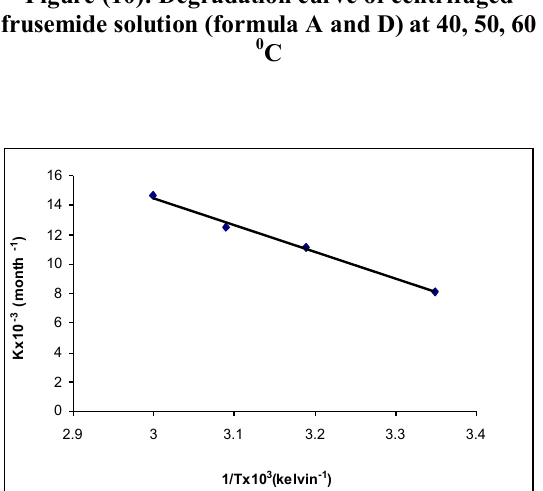
Figure (11): Arrhenenius plot of centrifuged frusemide solution (formula AandD) The expiration dates were found to equal 3 years for both formula A and D. The shelf life of calculated from the initial concentration and the apparent zero-order rate of degradation (K ) as the steps followed by estimation 0 of expiration data of formulas A and D